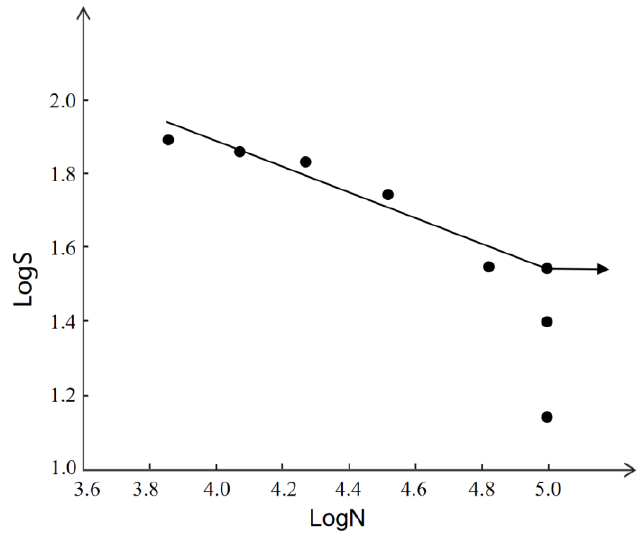
Figure 11. S–N curve of welded joint .